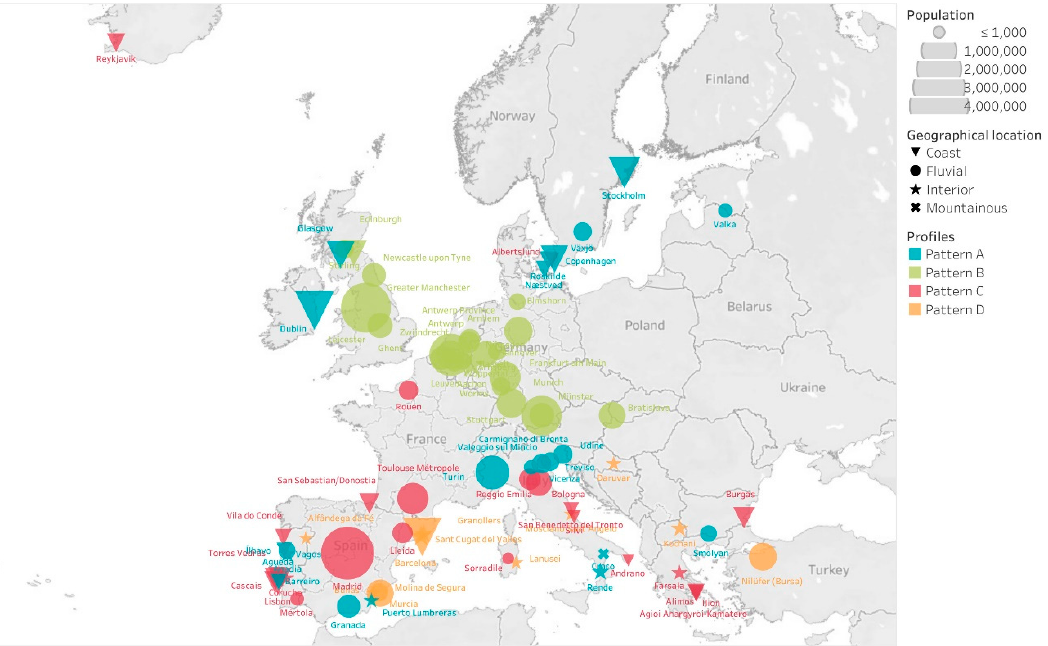
Figure 10. Spatial distribution of the four strategic patterns of initiatives found in the research among the 84 good practices of the Mayors Adapt initiative. The population of the city and the geographical location to which the municipality belongs are indicated. Source: compiled by the authors.